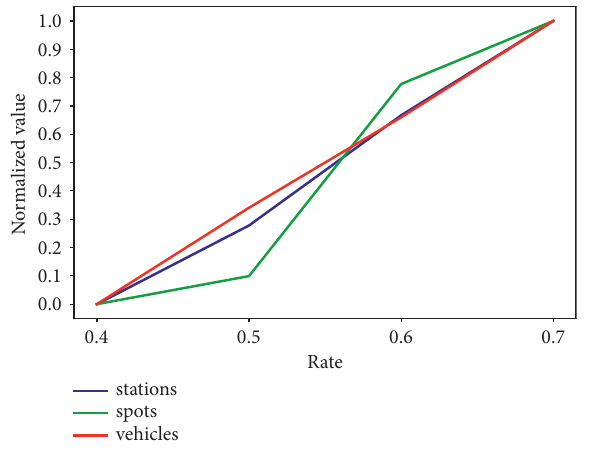
Figure 16: The results of the location